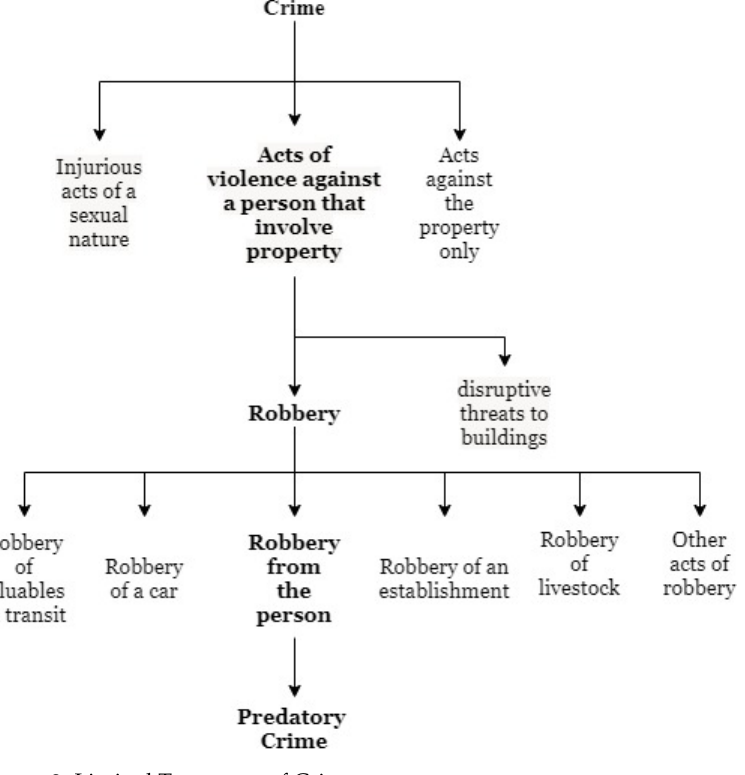
Figure 2. Limited Taxonomy of